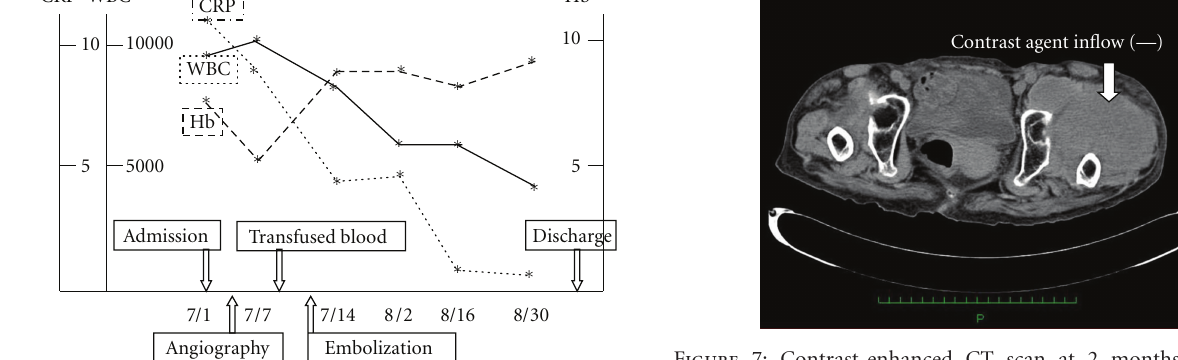
Figure 7: Contrast-enhanced CT scan at 2 months after the